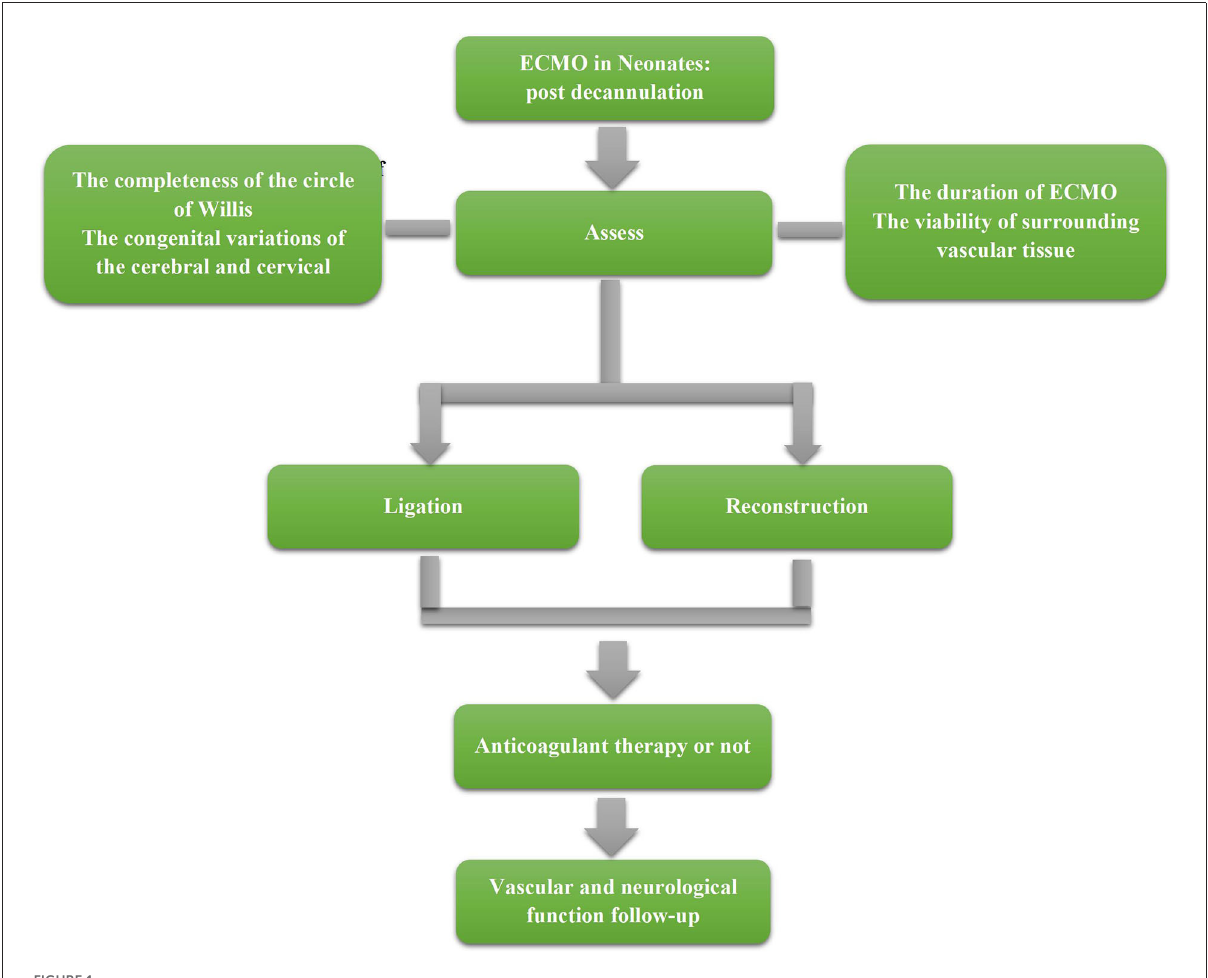
FIGURE1 The flow chart of vascular image management post